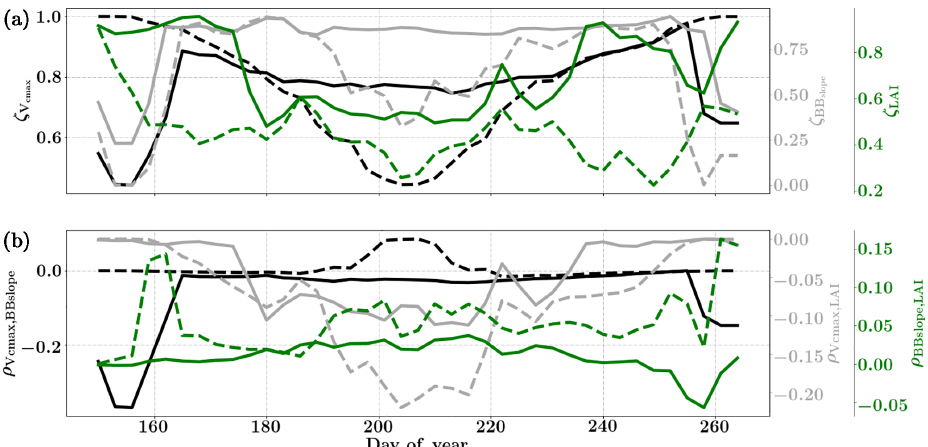
Figure 8. Figure showing the seasonal variability of the posterior error reduction ( ζ ) and correlation coefficient of the retrieved parameter values of V cmax , BB slope and LAI for the Nebraska Mead-1 site using a 3-day moving window inversion approach for the year 2010. Panel (a) shows the ζ V , ζ BB and ζ LAI for the entire growing season and (b) shows the correlation coefficients (normalized off- slope cmax diagonal elements of posterior error covariance matrix) among these variables. The results of retrievals using only GPP and LE fluxes are shown as dashed lines and the results using a combination of fluxes and MODIS reflectance are shown as solid lines. Both the ζ and correlation coefficients are computed using the final Jacobian matrix at the end of each retrieval